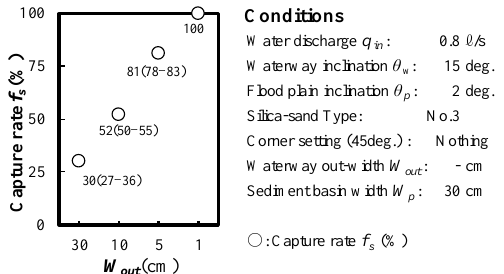
Figure 10. Effects of changes in the downstream opening width W out of the sediment retarding basins on the sediment capture rate f s .